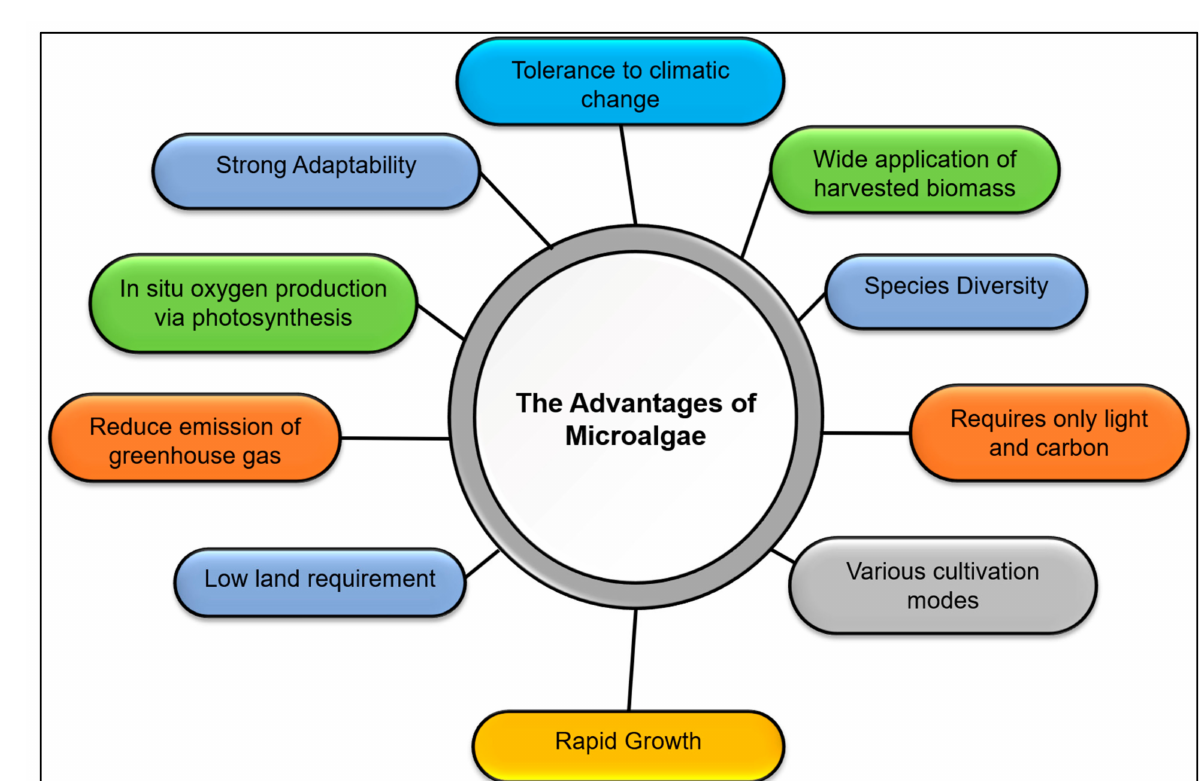
Figure 18. The benefits of